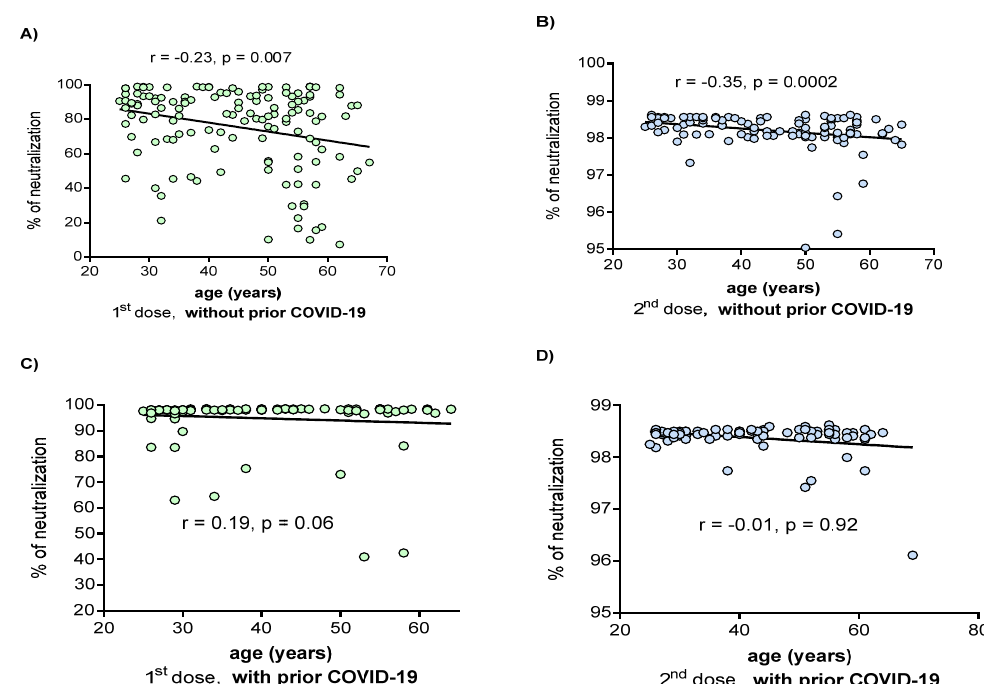
Figure 6. Correlation between the age and neutralization percentage in vaccinated individuals with and without prior COVID-19. ( A ) the first dose in patients without prior COVID-19; ( B ) the second dose in patients without prior COVID-19; ( C ) the first dose in patients with prior COVID-19; ( D ) the second dose in patients with prior COVID-19. Correlations were evaluated by the Spearman test. Outliers were removed for data analysis.